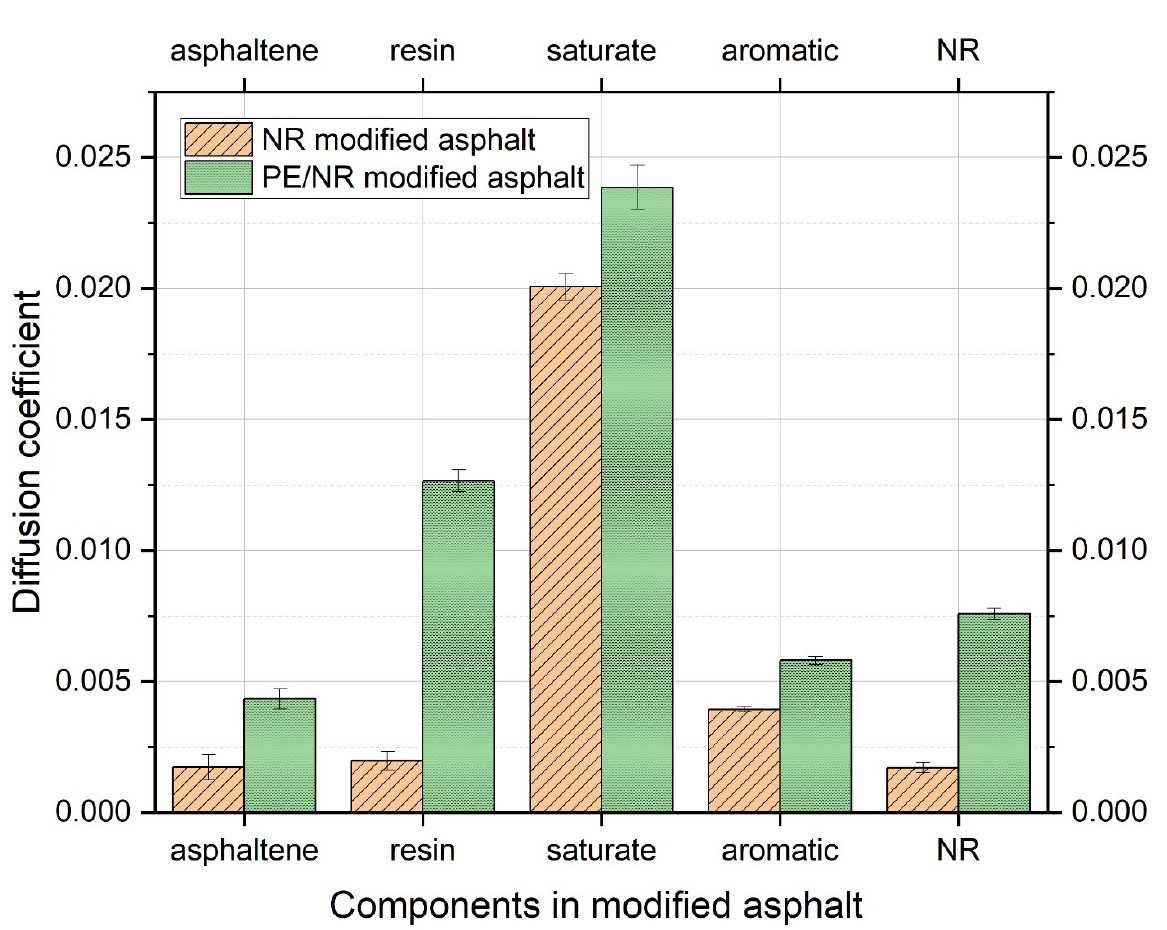
Figure 9. Diffusion coefficient of each component in NR modified asphalt and PE/NR modified as- phalt.